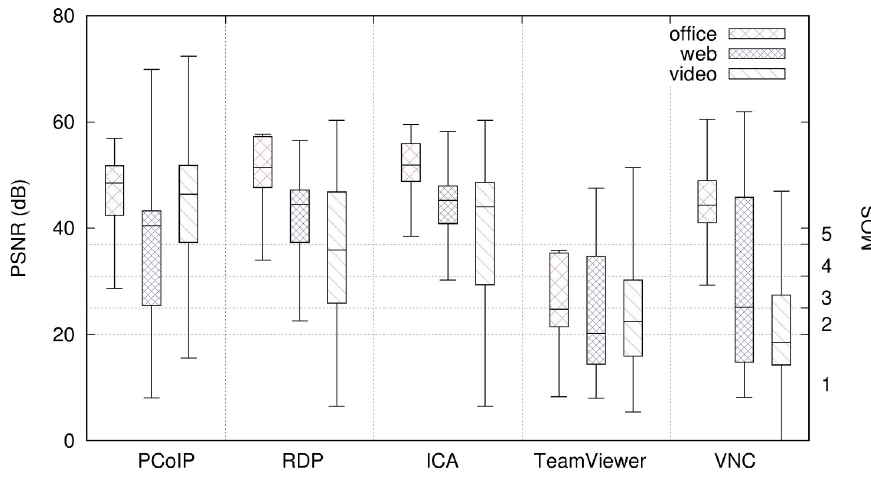
Fig 12. Comparison of PSNR per user profile and remote desktop